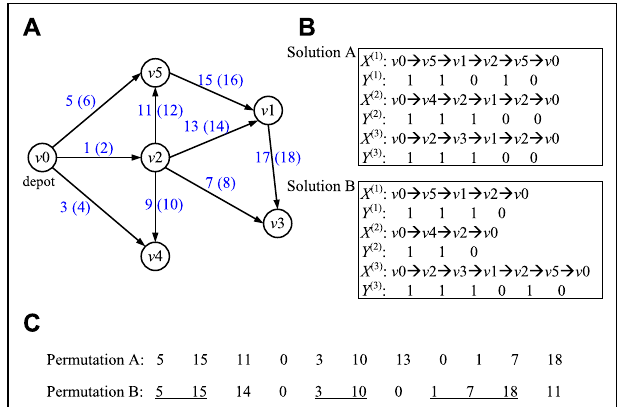
FIGURE 3 | (A) UCARP instance example, (B) two possible solutions for the UCARP instance in (A) , and (C) the corresponding two permutations of tasks based on the solutions A and B in (B) .